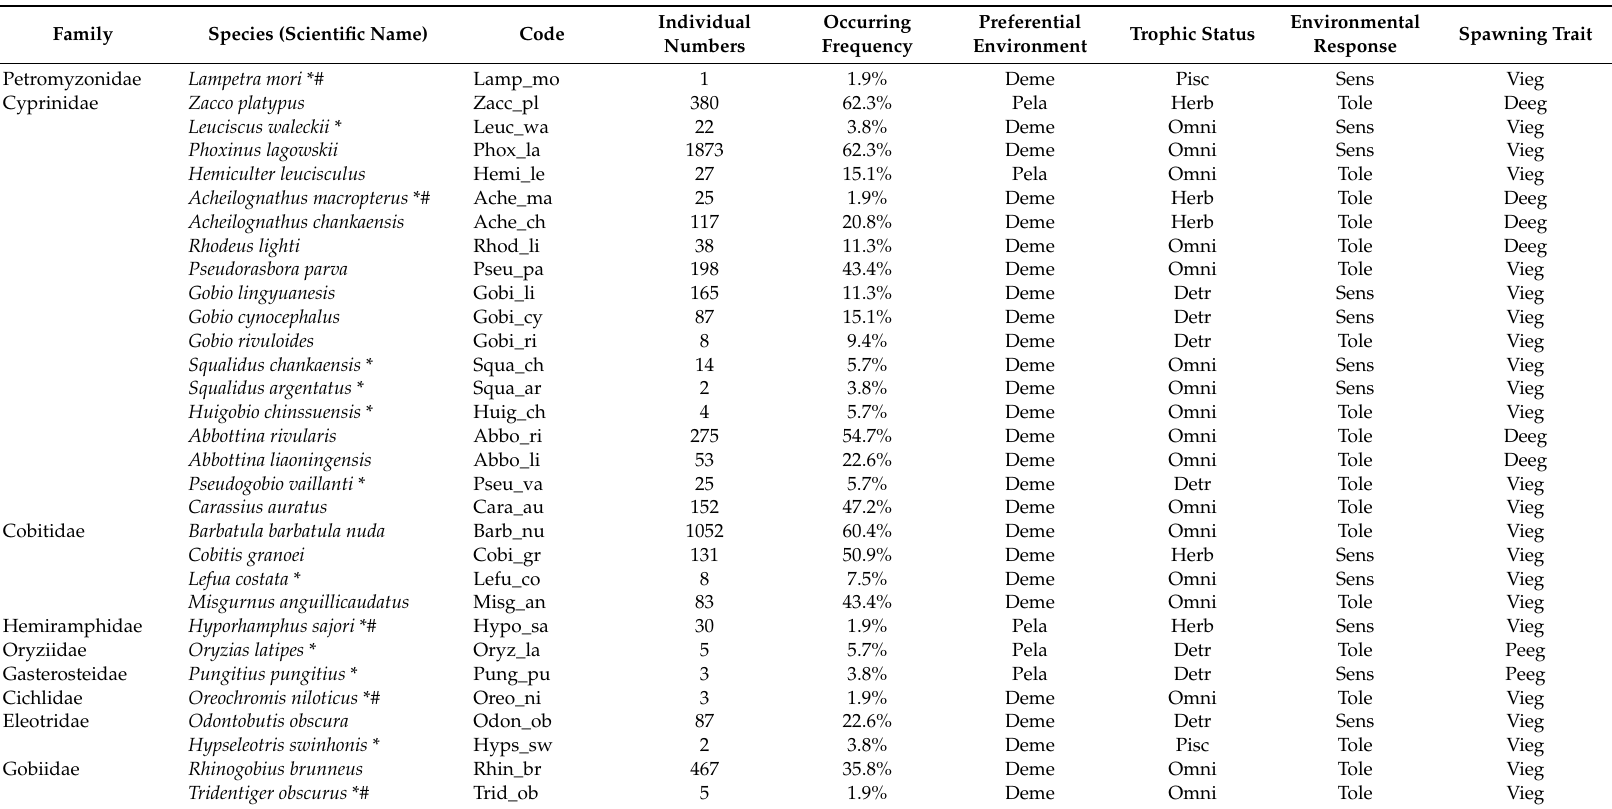
Table 1. Species composition, abundance and ecological characteristics of fish species recorded in the Taizi River catchment (* species not used for TITAN analysis as they were recorded at less than five sites; # species excluded from pCCA as they were only recorded at a single site. Deme = demersal, Pela = pelagic. Pisc = piscivorous, Omni = omnivorous, Herb = herbivorous, Detr = detritivorous. Sens = sensitive, Tole = tolerant. Peeg = pelagic-egg, Deeg = demersal-egg, Vieg =